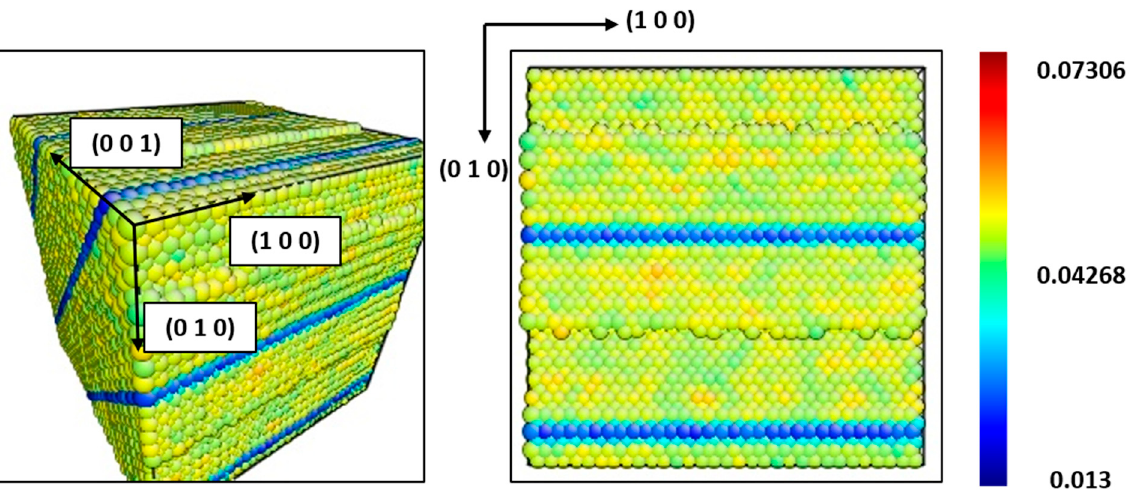
Figure 5. Atomic structure from simulation domain at 10 K under normal stress of 0.1 GPa. Atoms were colored by local von Mises shear strain invariant. Martensite twin was formed as (0 1 1) (1 0 0).